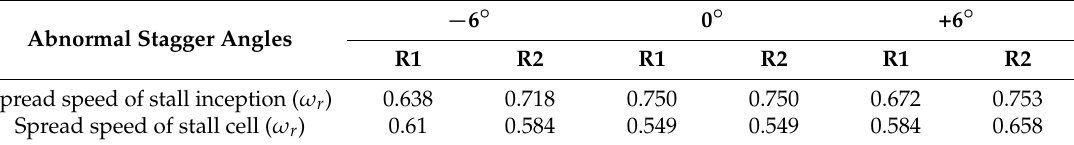
Table 4. Circumferential propagation velocity of stall inceptions and stall